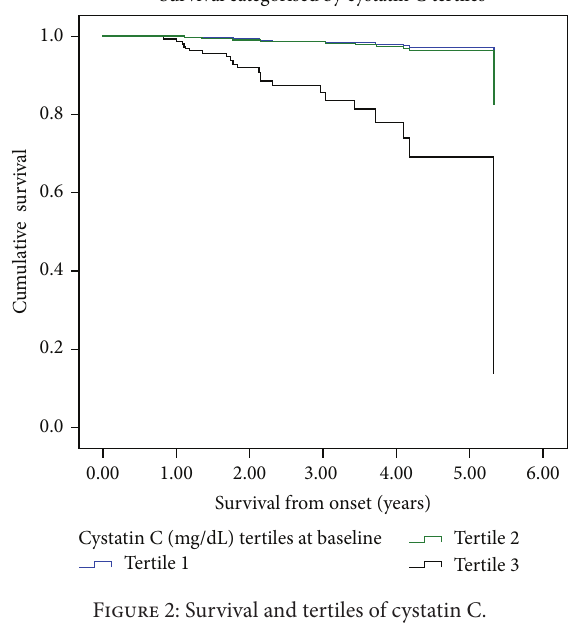
Figure 2: Survival and tertiles of cystatin C.